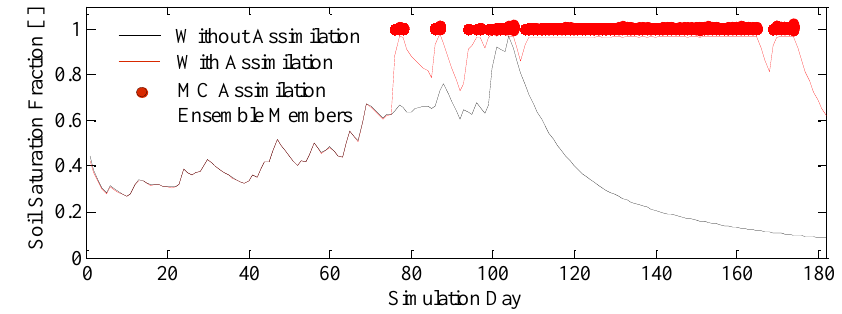
Figure 16. Soil saturation fraction with no assimilation (black line), each member of the Monte Carlo ensemble estimates after assimilation (red dot), and the soil saturation fraction for each day after data assimilation (red line).